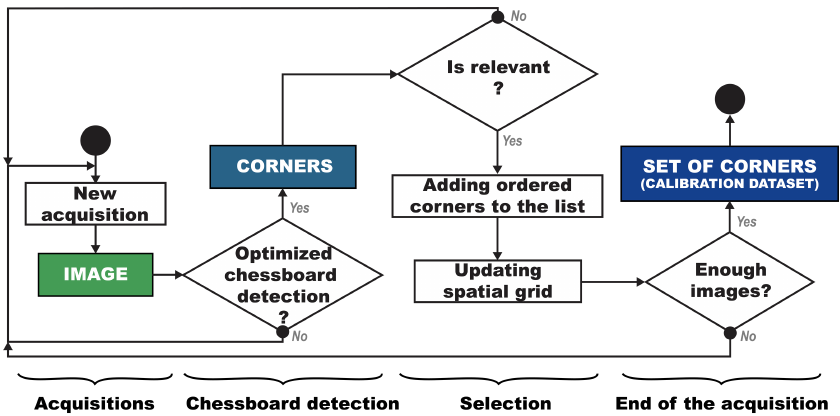
Figure 2. Flowchart of the algorithm that automatically selects a set of calibration images during an